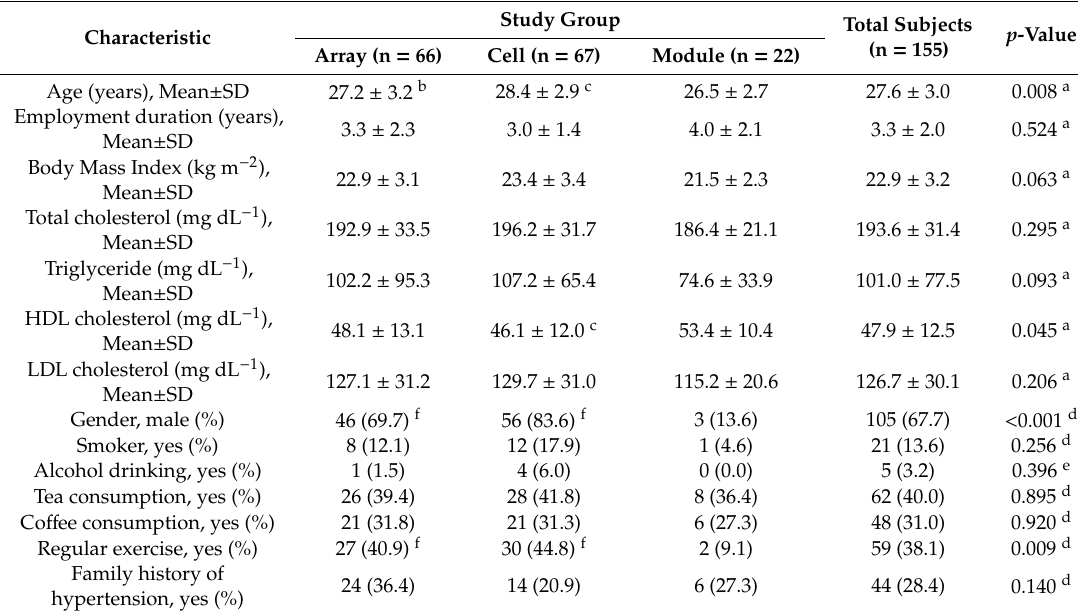
Table 1. Demographic characteristics of participants by